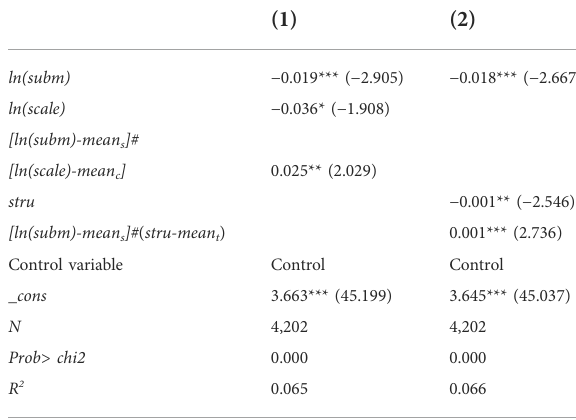
TABLE 3 Effect of agricultural subsidies on fertilizer application intensity: heterogeneity